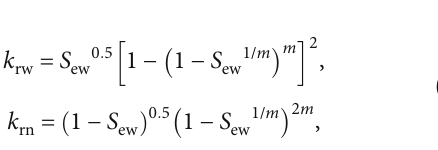
Figure 6: Predicted relative permeability for (a) water-oil system and (b) oil-gas system as well as the comparison to the experimental data.